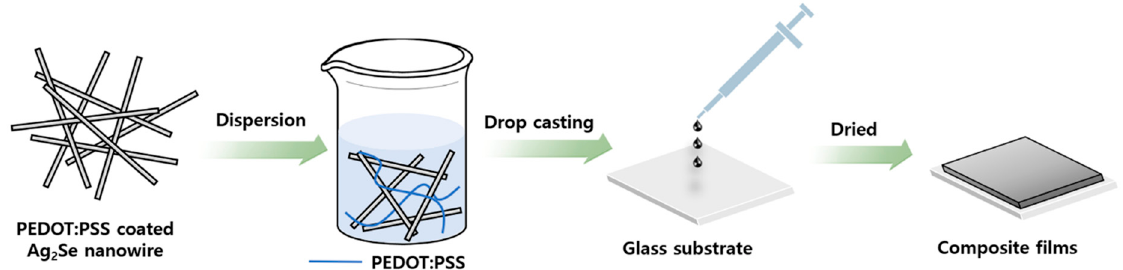
Figure 5. A schematic diagram of the preparation process for the PEDOT:PSS-coated Ag 2 Se NW/PEDOT:PSS composite films.